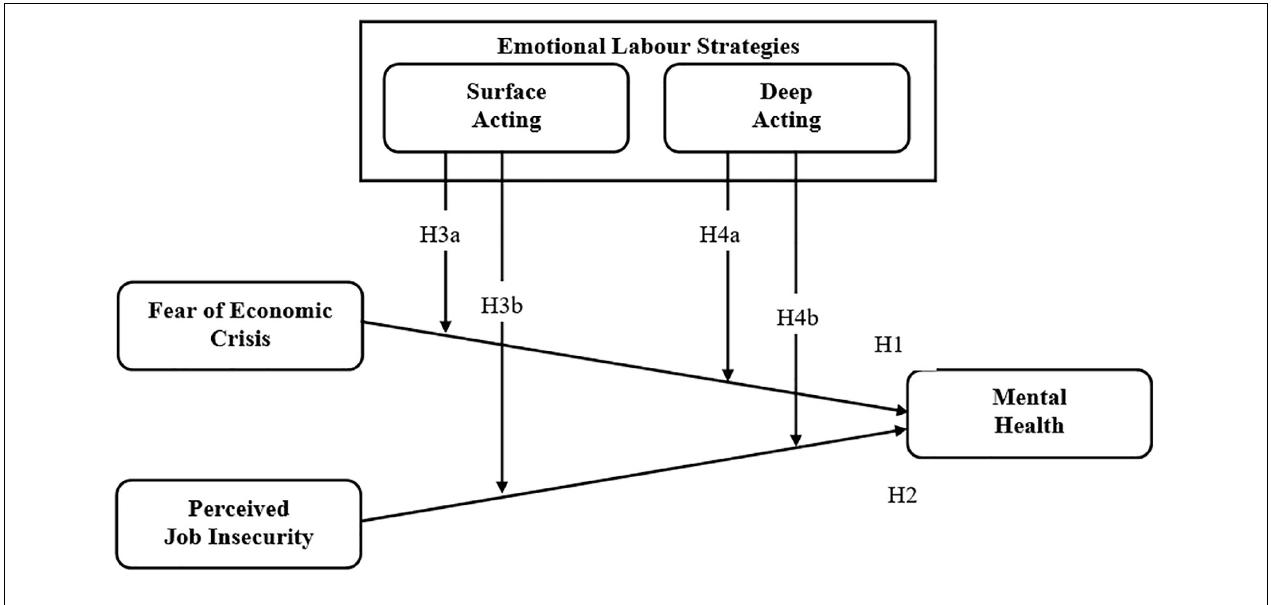
FIGURE 1 | Conceptual